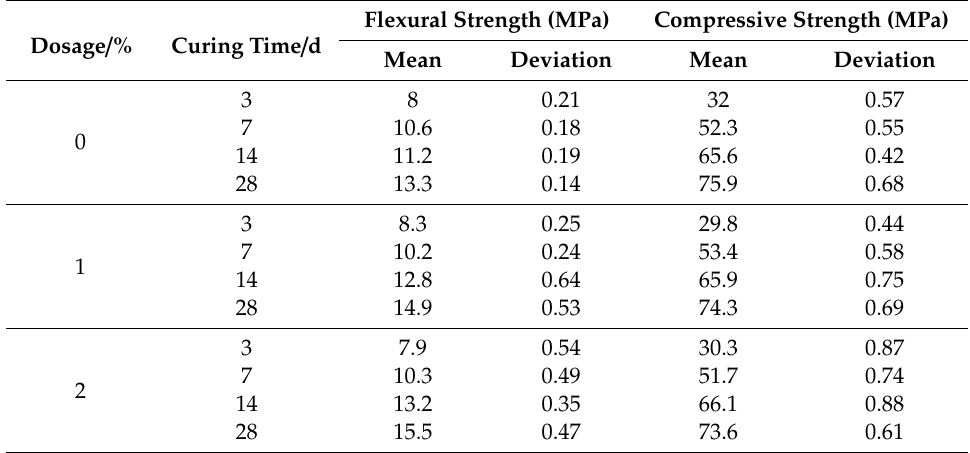
Table 7. Test results of the flexural strength and compressive strength of